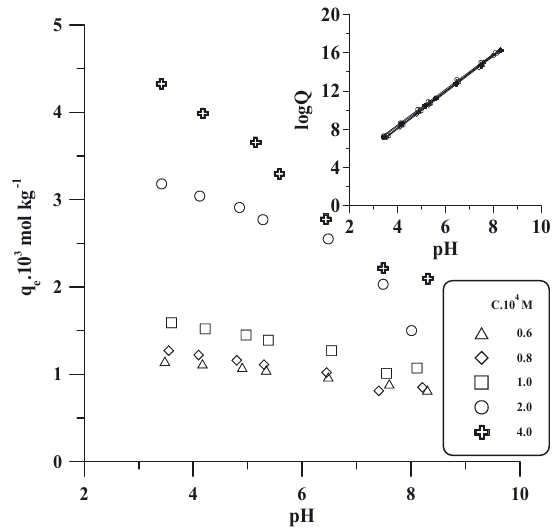
Figure 3. pH dependence of MCPA adsorbed at various concentra- tions. (pH dependence of logarithmic equilibrium quo- tients is shown in the